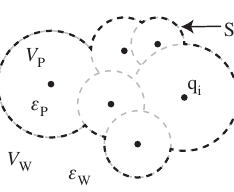
is defined in terms of a collec- P and the protein charge P obeys a Poisson P , that W ; here, W